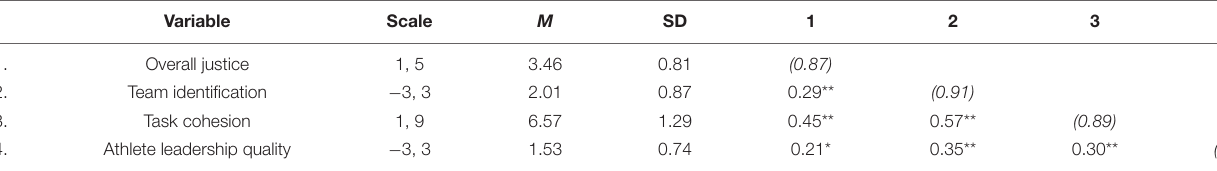
TABLE 1 | Scales, means, standard deviations correlations, and Cronbach’s alphas for all variables.